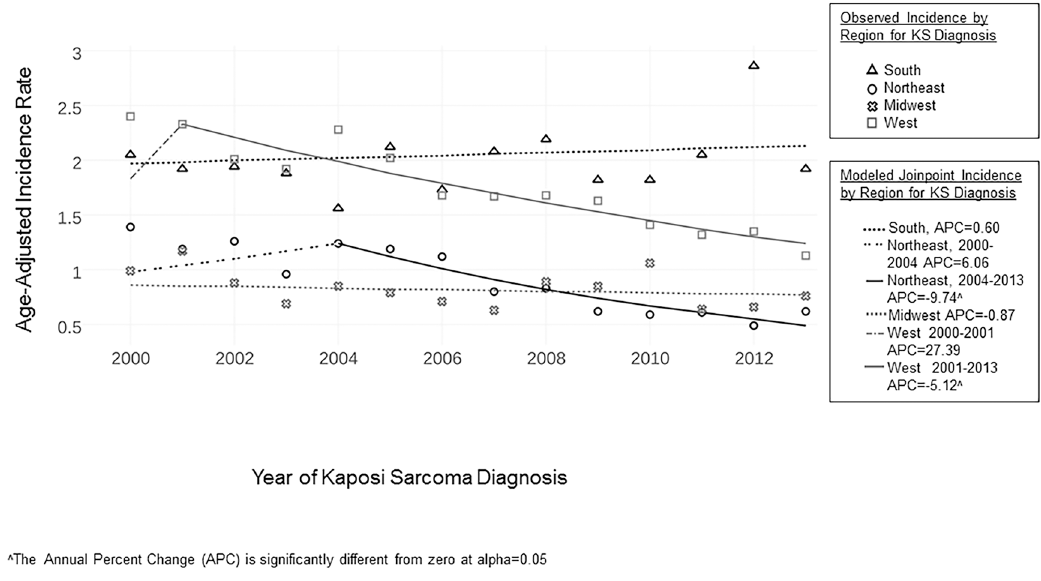
Fig 2. KS incidence in the U.S. by geographic region, 2000–2013.